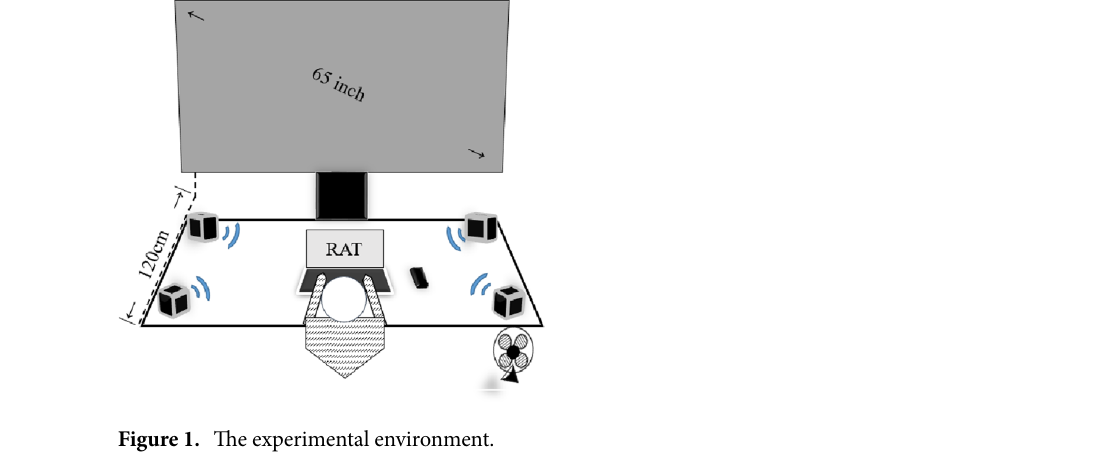
Figure 1. The experimental